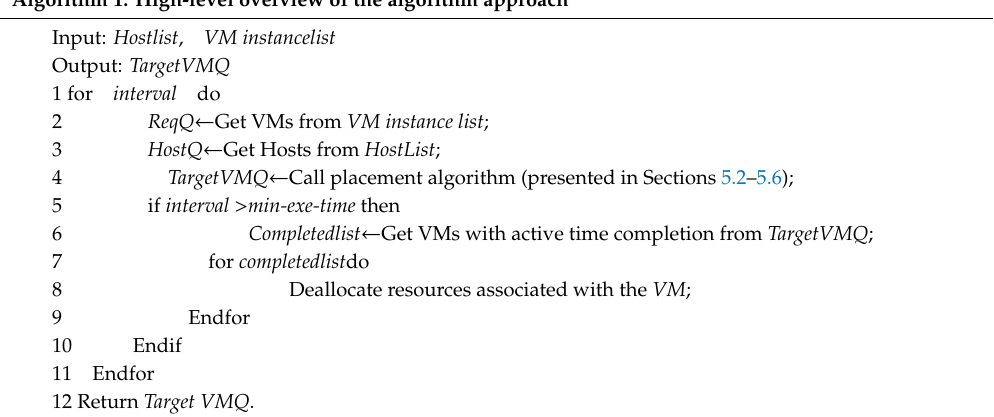
Algorithm 1: High-level overview of the algorithm approach